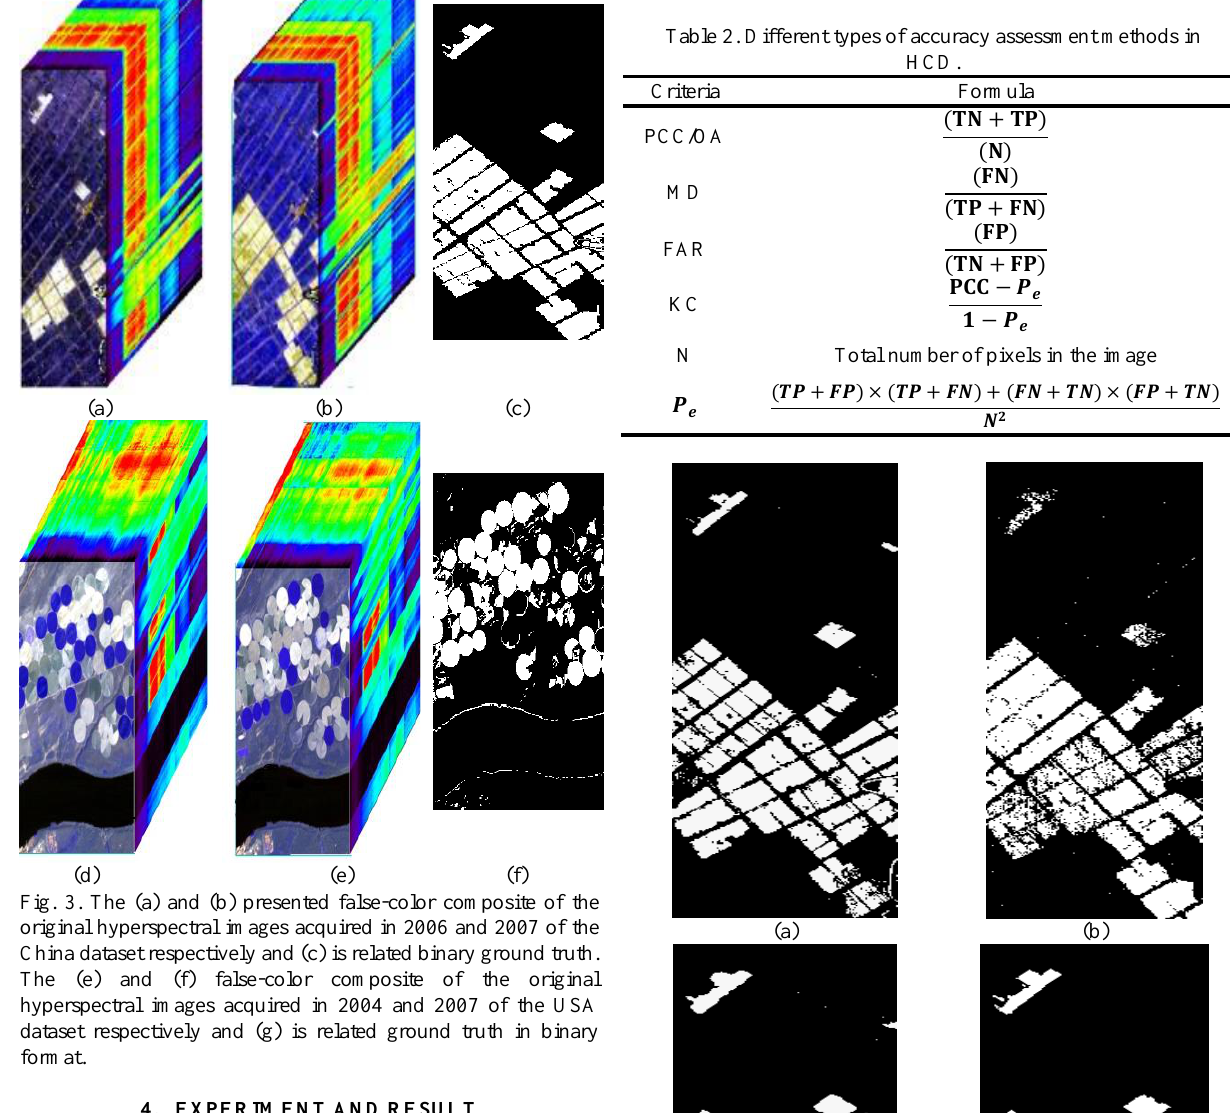
Table 2. Different types of accuracy assessment methods in HCD.